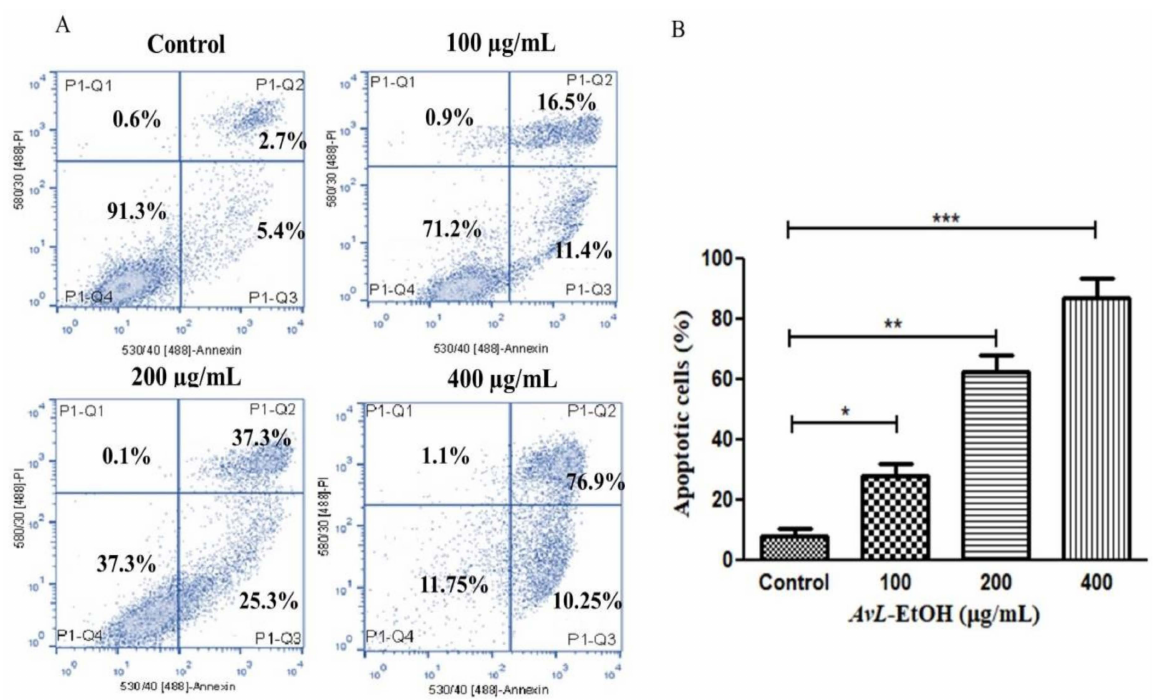
Figure 5. ( A ) Flow cytometric evaluation of apoptosis instigated within A549 cells post treatment with varying concentrations of AvL -EtOH (100, 200 and 400 µ g/mL) and ( B ) graphical representation of flow cytometric data of apoptosis. * p < 0.05, ** p < 0.01 and *** p < 0.001.